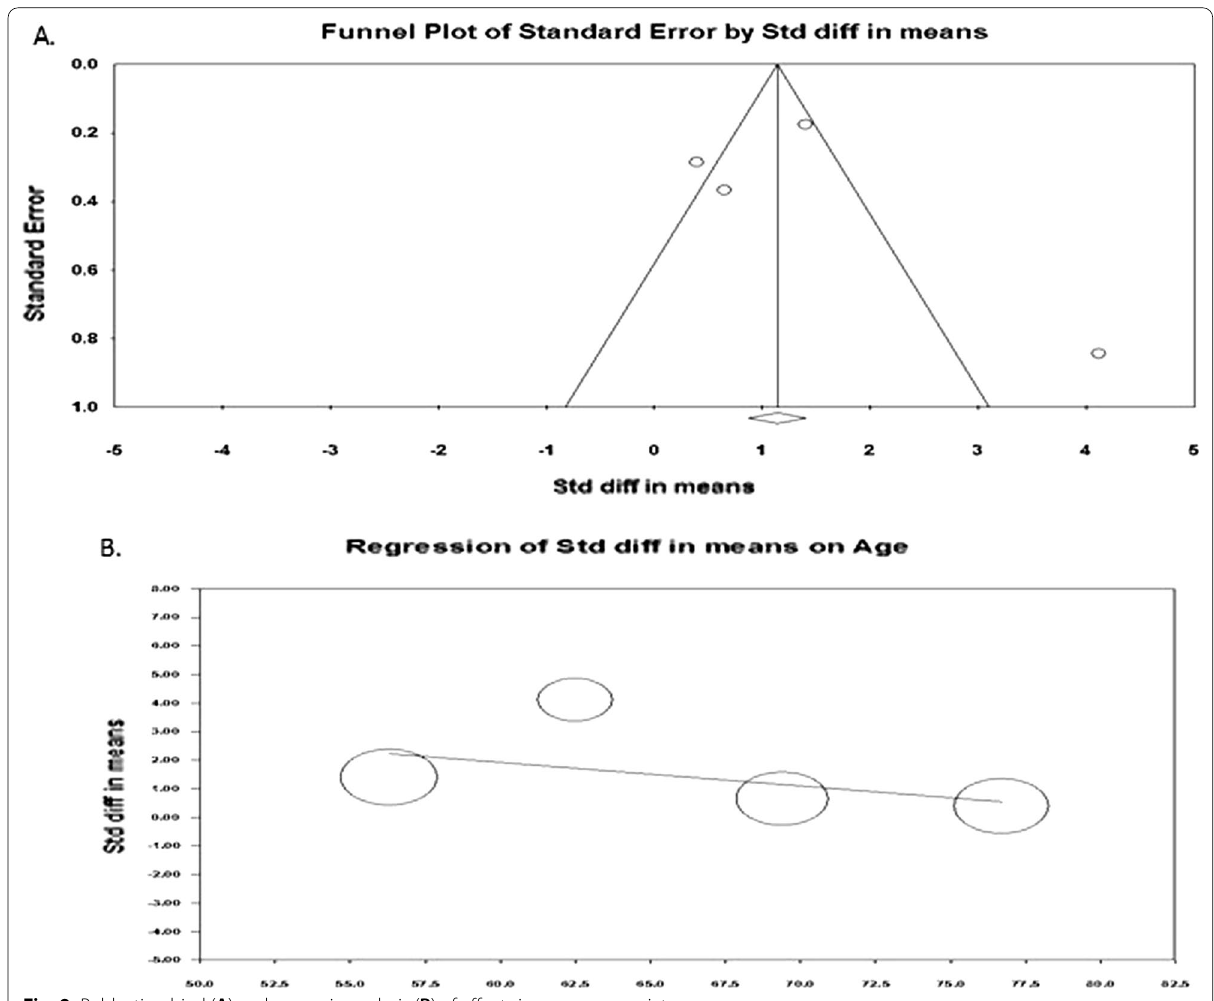
Fig. 9 Publcation biasl ( A ) and regressin analysis ( B ) of effect size on age